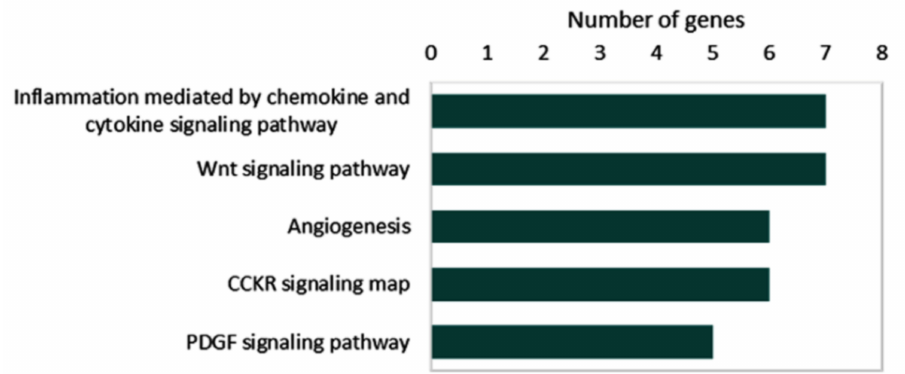
Figure 7. Pathway enrichment analysis for overexpressed genes caused by upregulated circRNAs. Data source: “PANTHER (Protein ANalysis THrough Evolutionary Relationships) Classification System (http://pantherdb.org (accessed on 23 June